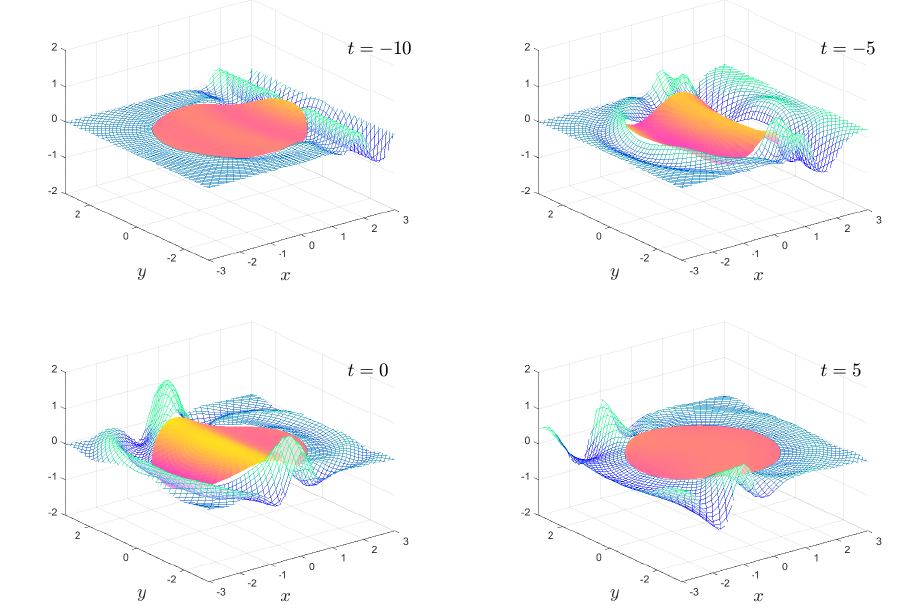
Figure 4. As in Figure 2, except β = 1 × 10 − 3 . The full animation can be found in movie